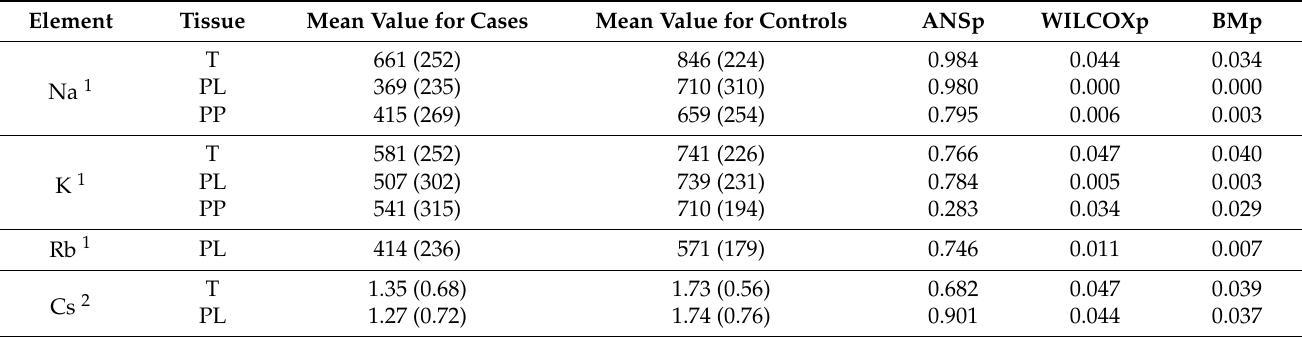
Table 1. The results of the statistically significant differences between controls ( n = 20) and